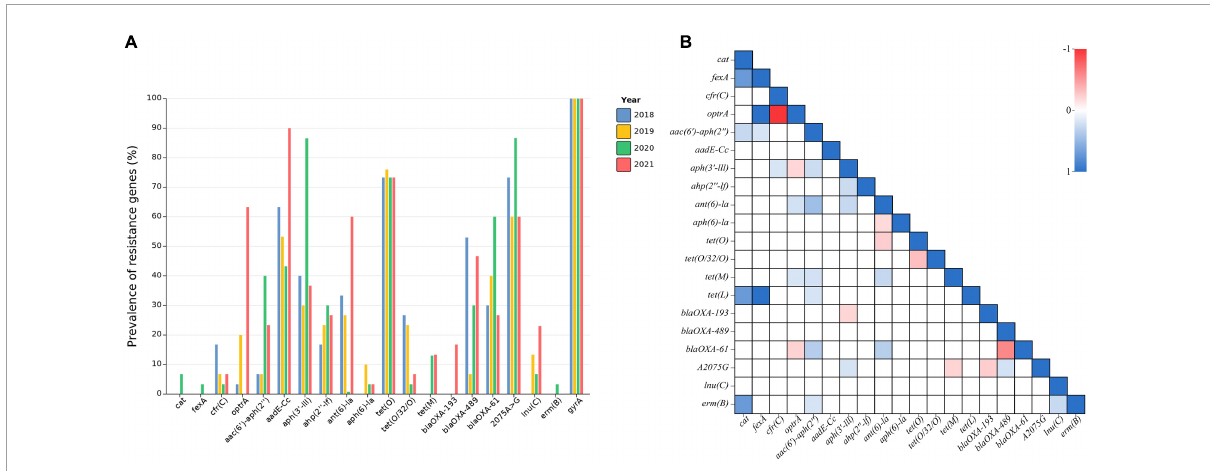
FIGURE2 Antibiotic resistance genes in Campylobacter isolates. (A) The distribution of resistance genes in Campylobacter isolates. (B) Co-occurrence of ARGs in Campylobacter . Significant pairwise values from 1 (blue) to − 1 (red) (that is, co-occurrence and mutual exclusivity) are